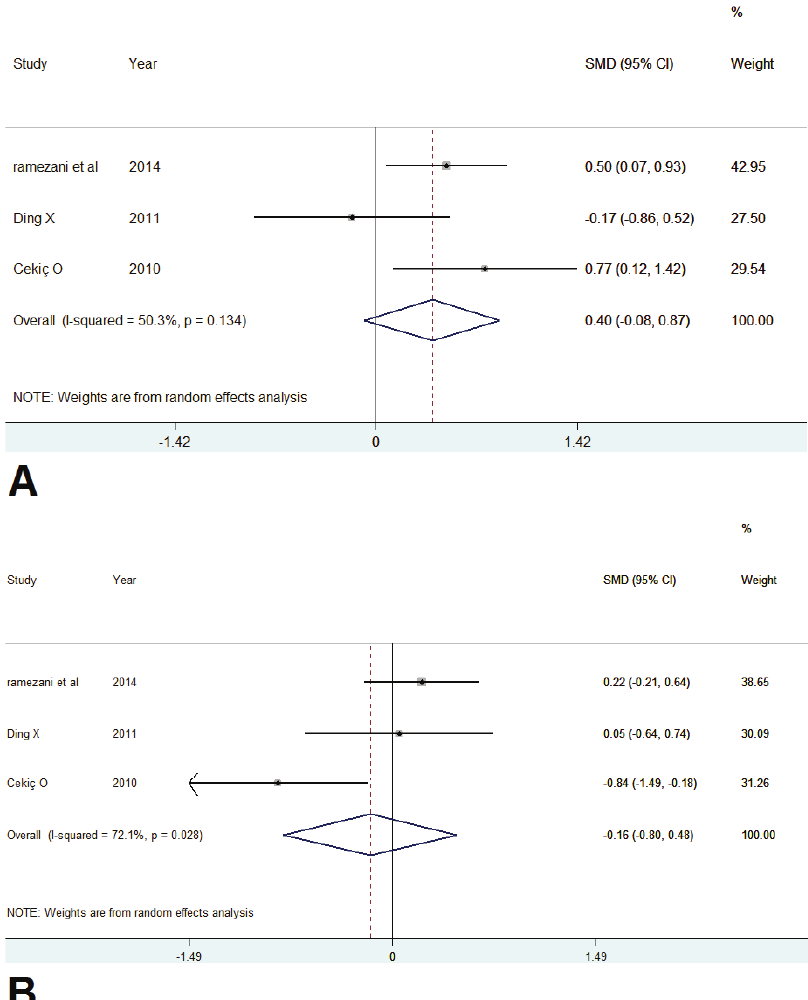
Figure 3. Forest plot displaying pooled summary estimates with bevacizumab treatment versus triamcinolone injection at 24 weeks. (a) Regarding VA, since there was no significant heterogeneity (I2 = 50%, p = 0.13), either fixed-effect or random- effect analysis was applied or the overall 95%CI was not meaningful (-0.08 to 0.87). (b) Regarding CMT, there was significant heterogeneity between included studies (I2 = 72%, p = 0.02) and thus, the random-effect model was used and the overall 95%CI was not meaningful (-0.80 to 0.48). CI, confidence interval; CMT, central macular thickness; VA, visual